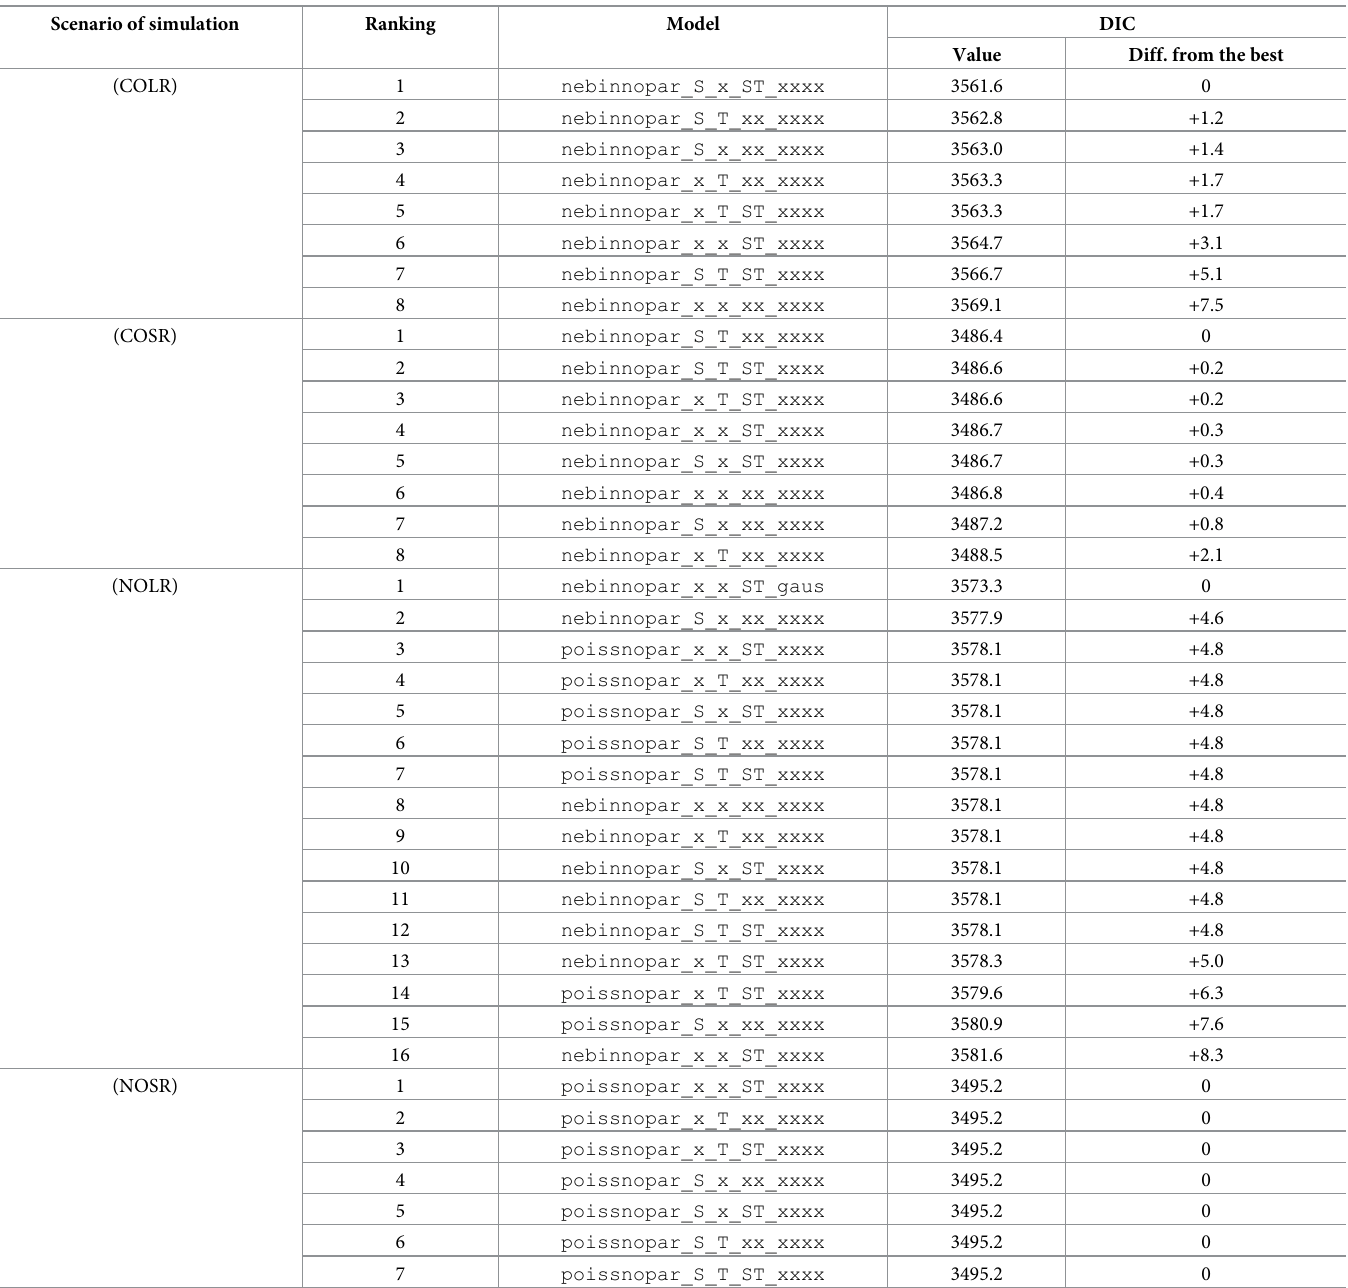
Table 2. Best models according to the